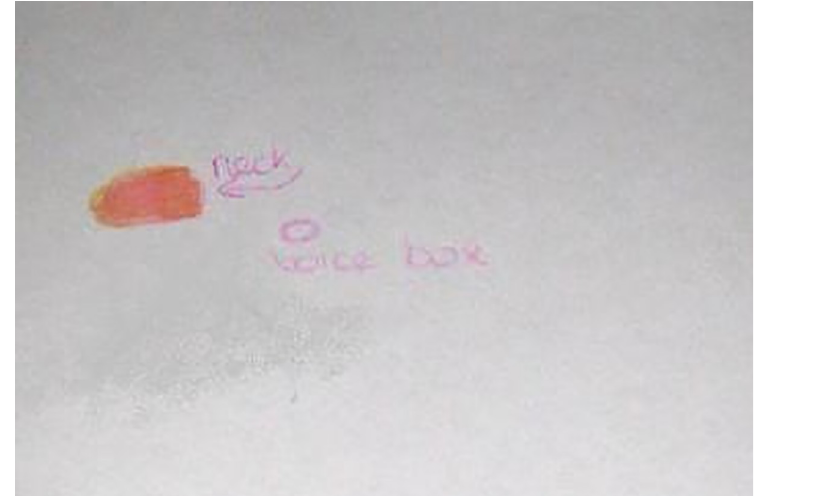
Fig 6. Katrina, T1, Lump in her neck.